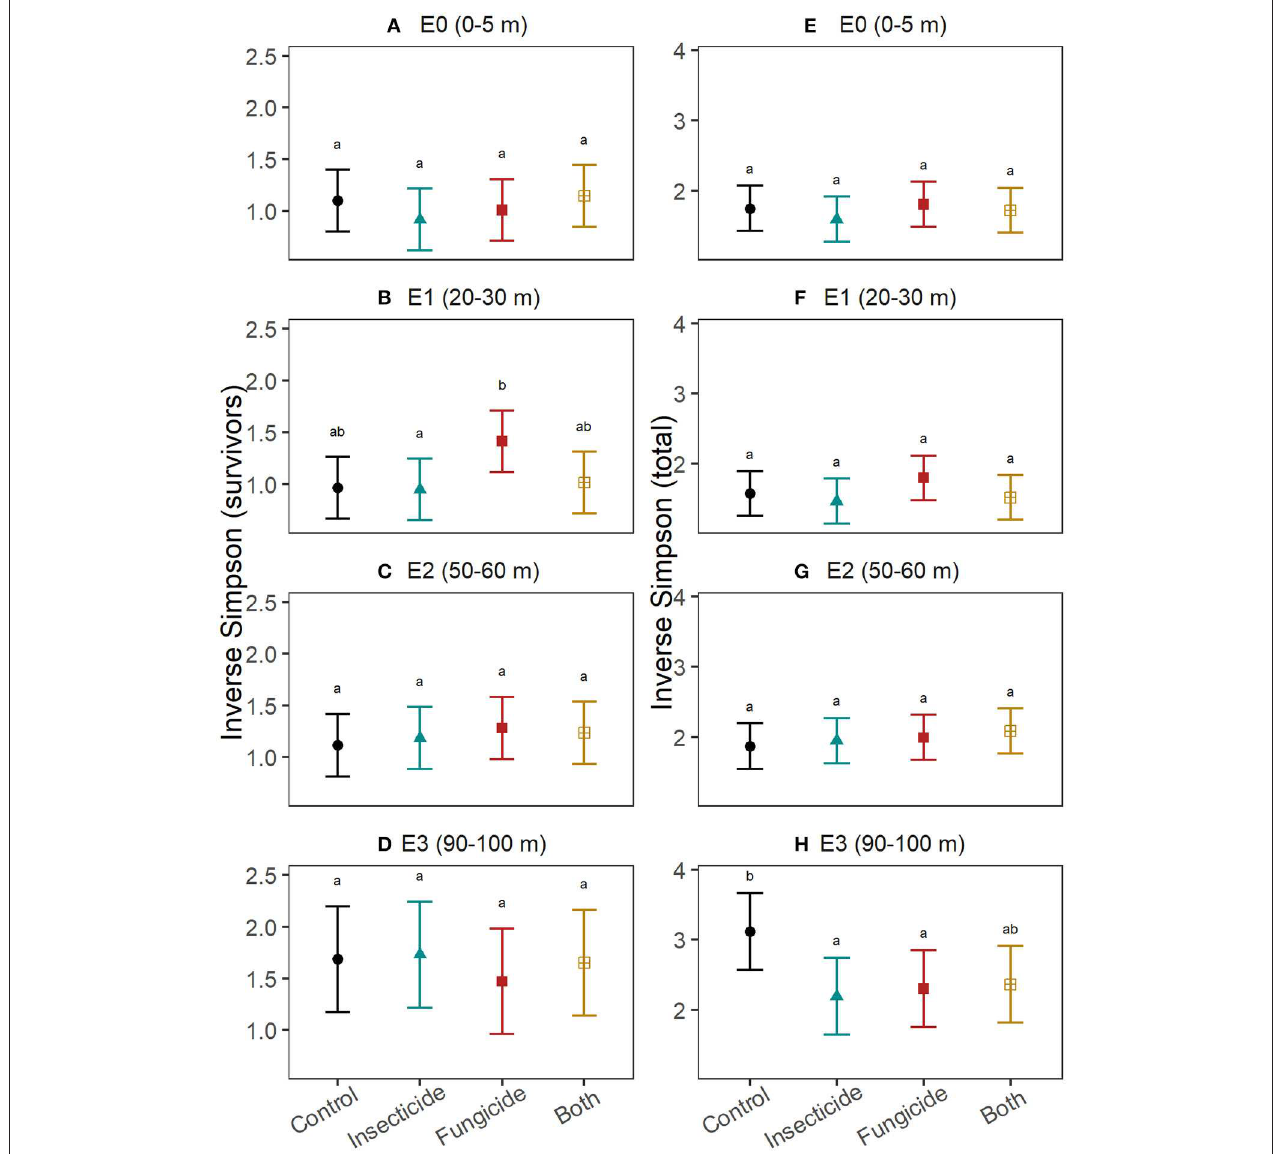
FIGURE 3 | Effects of insects and fungi on seedling diversity. Through an annual recruitment cycle, at increasing distances from the forest edge, the effect of suppressing fungi and insects on (A–D) diversity of established seedlings alive at the end of the experiment and (E–H) total seedling diversity (i.e., both survivors and new recruits). For each response, patterns were assessed using linear mixed effects models with stations included as random intercepts. Points show the estimated mean and error bars are the associated 95% confidence intervals. Letters denote significance (at alpha = 0.05) of pairwise comparisons within each edge-category assessed using Tukey’s post-hoc tests with P-value correction for multiple